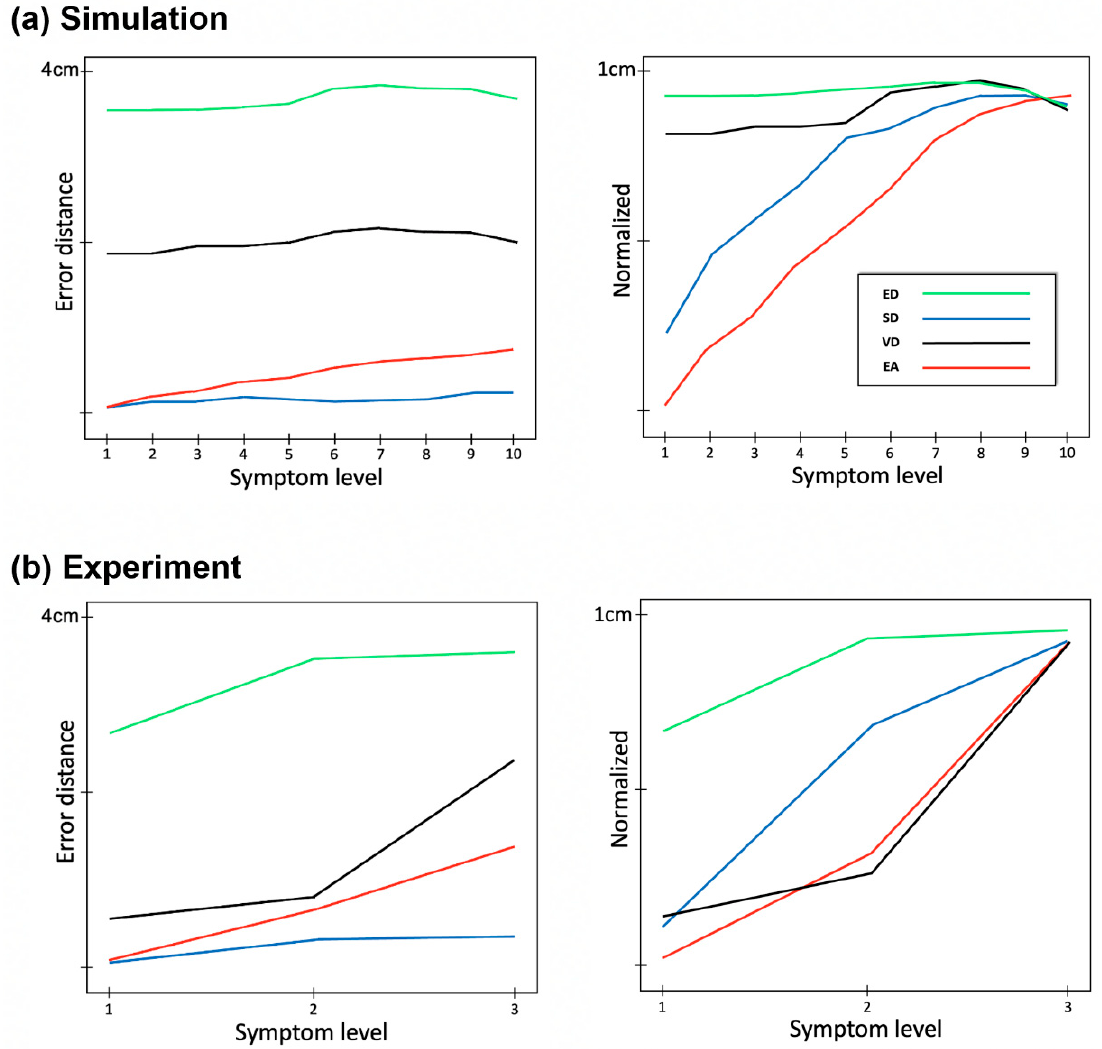
Figure 7. Comparison of error distances for each error stage between experimental data and simulation data. Error distance is shown as a function of symptom level from normal to severe in simulation data with 10 levels ( a ) and experiment data with 3 levels ( b ). The figures on the right are the normalized results. For all cases, the best and the worst levels show significant differences ( p < 0.05, from Wilcoxon Rank Sum Test).